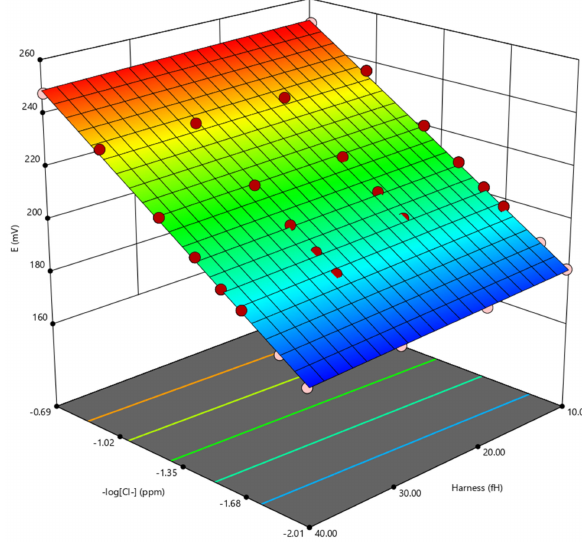
Figure 4. 3D plot obtained using the multivariate